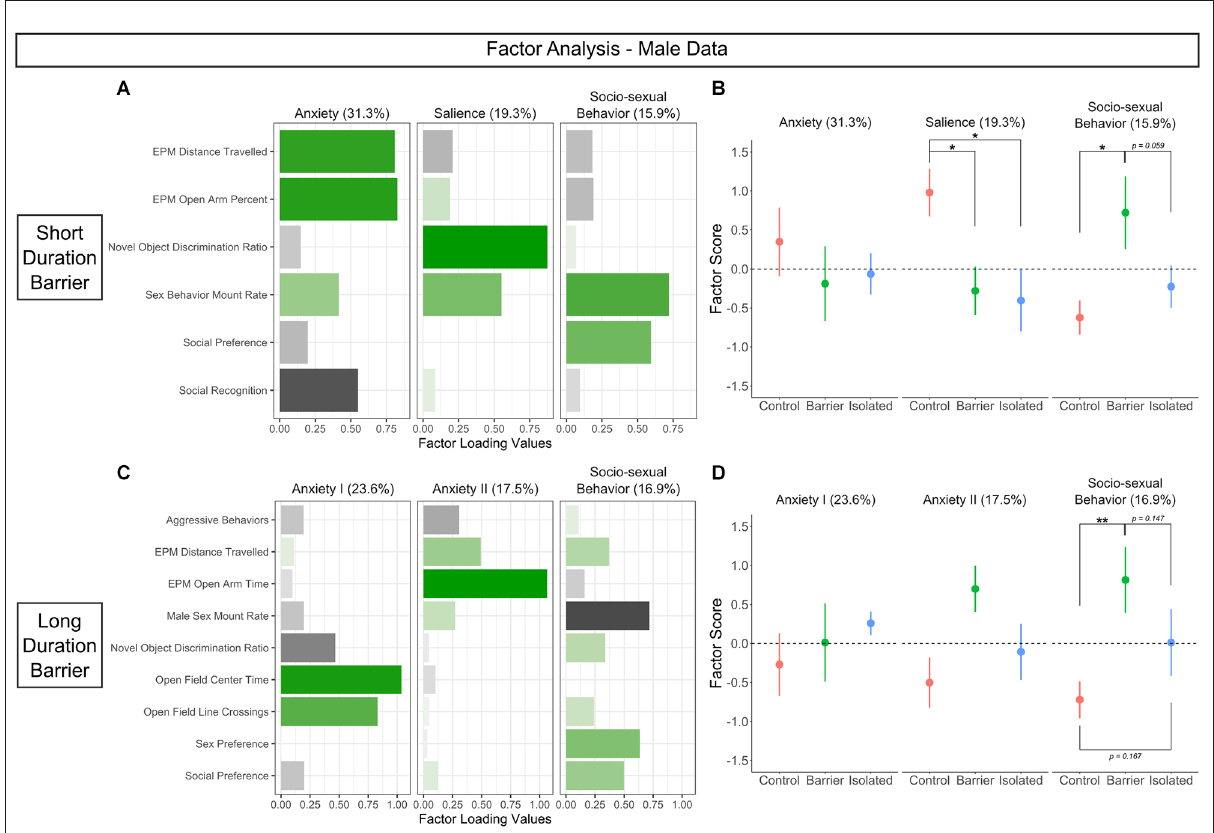
FIGURE11 Factor analysis indicates that juvenile play deprivation preferentially affects socio-sexual behavior in adult males. (A,C) Behavior factor loadings for each named factor for the short and long duration barrier studies, respectively. Longer, more saturated bars indicate stronger loadings, with green denoting positive loading and black indicating negative loading. (B,D) Loading scores for CTRL, BARR, and ISO males plotted for each factor for the short and long duration barrier studies, respectively. The values in parentheses represent the percentage of total variance accounted for by each factor. Filled circles indicate group means ± SEM. * p < 0.05, ** p < 0.01, n = 6–9 per